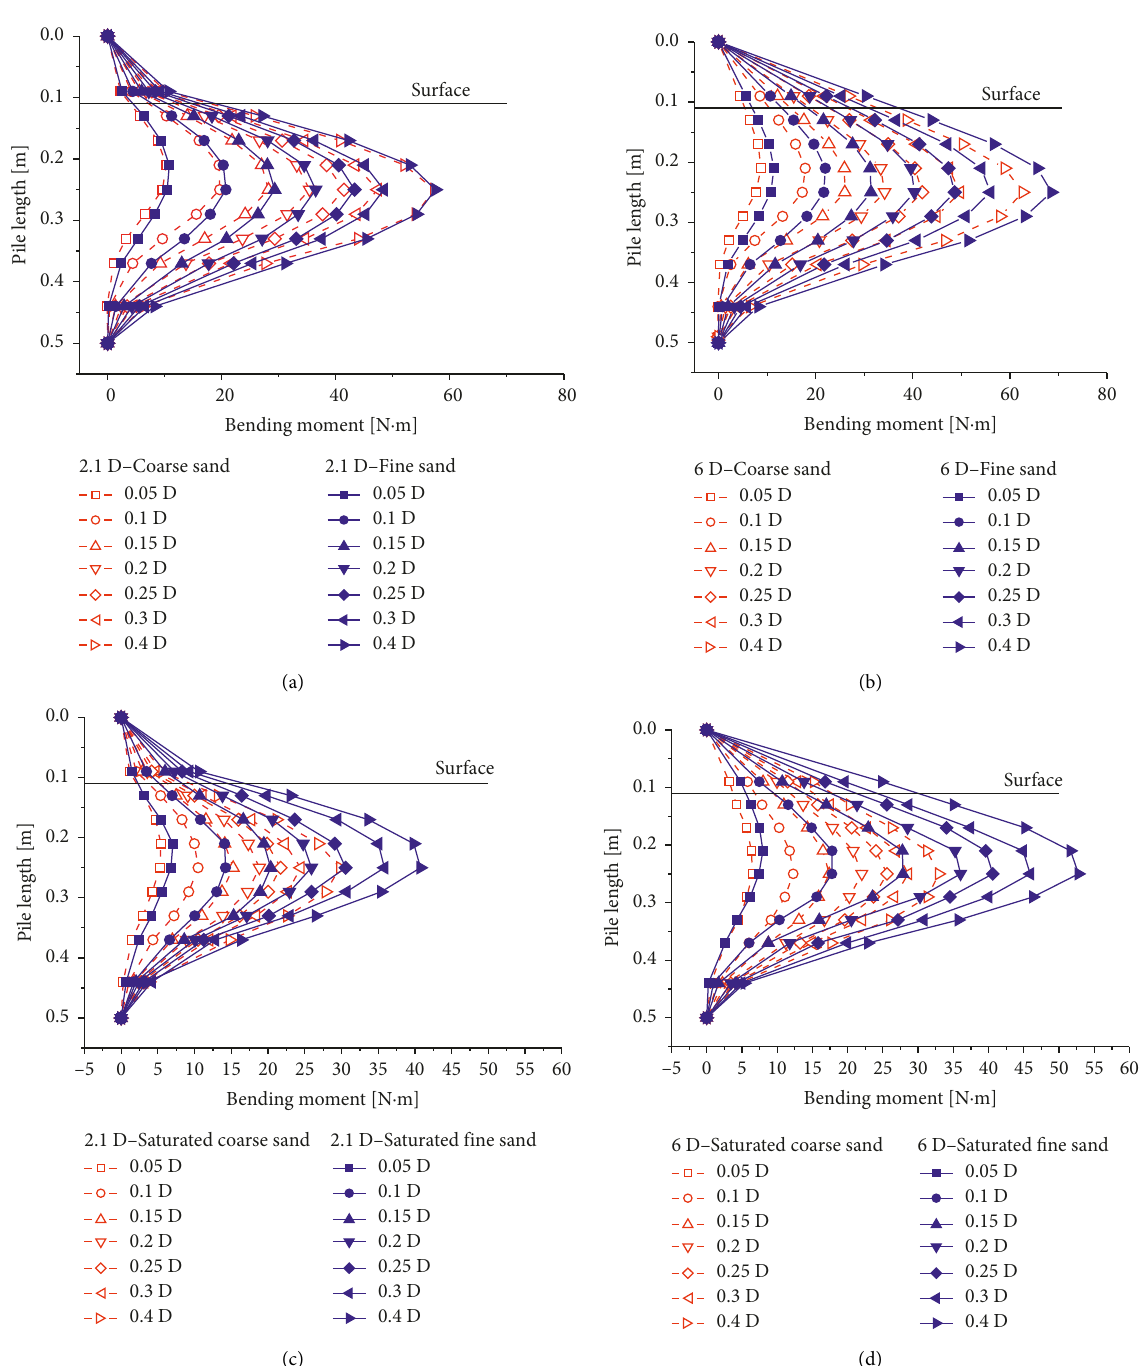
Figure 7: Comparison of bending moment in fine and coarse sand, (a) 2.1D dry sand, (b) 6D dry sand, (c) 2.1D saturated sand, and (d) 6D saturated